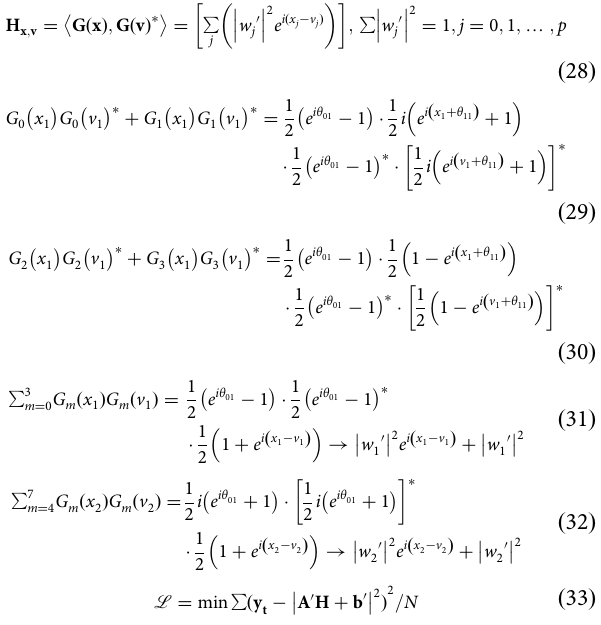
The difference between ONN and PPC is summarized in Table 1. As seen, the PPC differs from ONN in equation expression, data input, and device operators. It does not utilize activation functions as used by ONN. For PPC, the data to